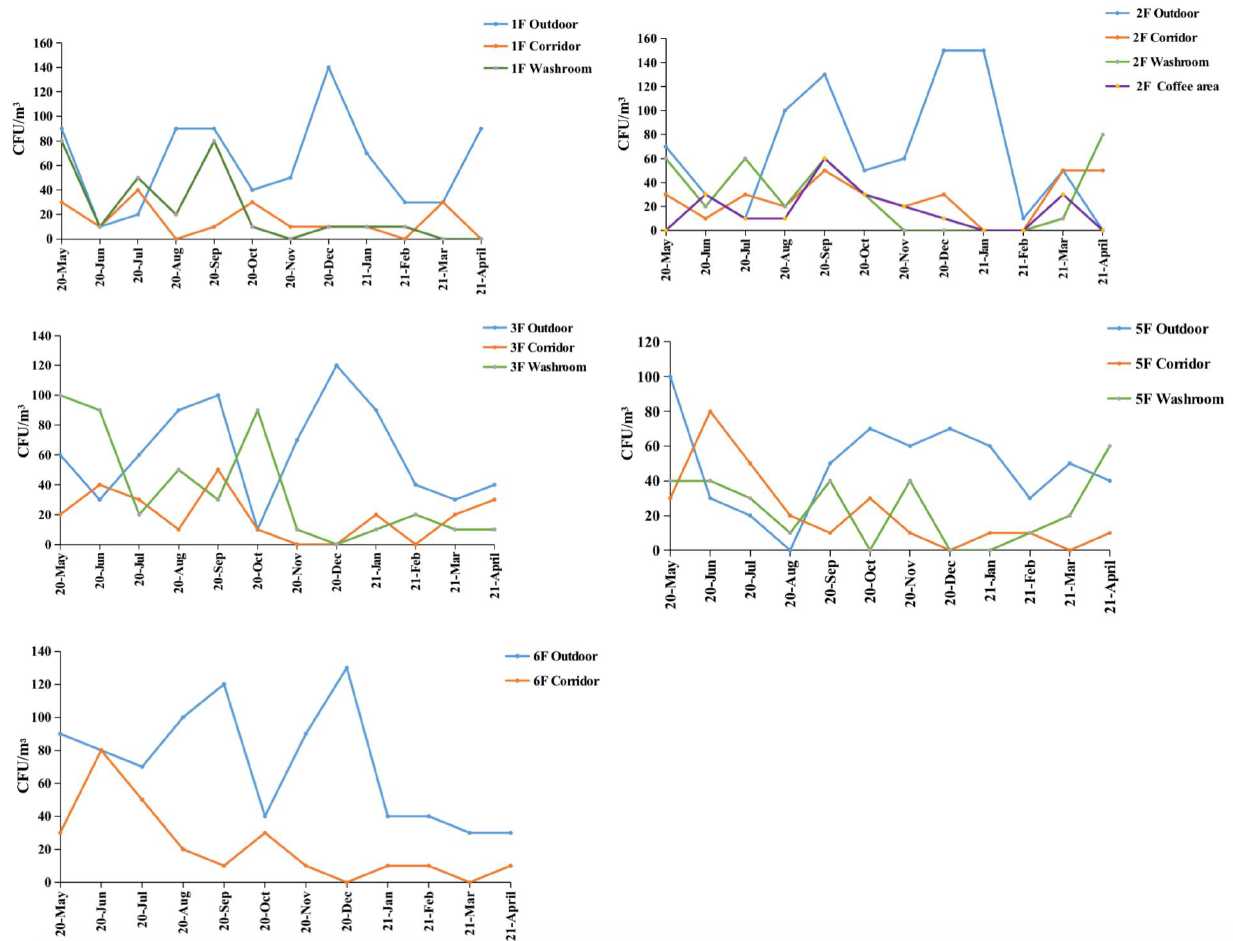
Figure 7. Annual variation of fungal concentration at each